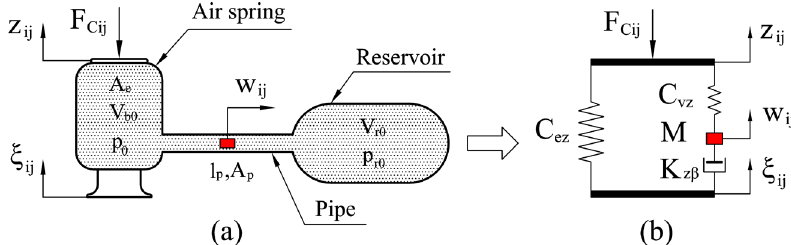
Figure 3. Model of the air suspension system: ( a ) Physical model, ( b ) GENSYS model. Displacements z ij , ξ ij , and w ij are the displacements of the upper part of the air spring, the lower part of the air spring, and of the air flow inside the pipes, respectively.